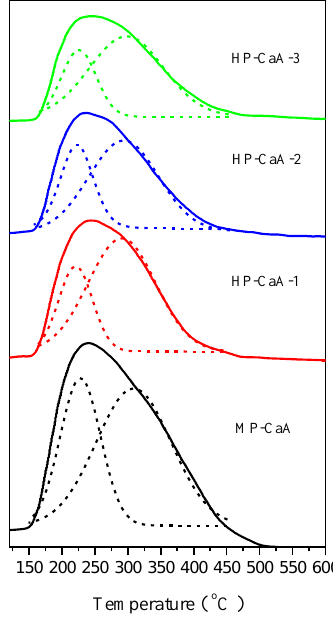
Figure 4. NH 3 -TPD curve of the CaA samples.